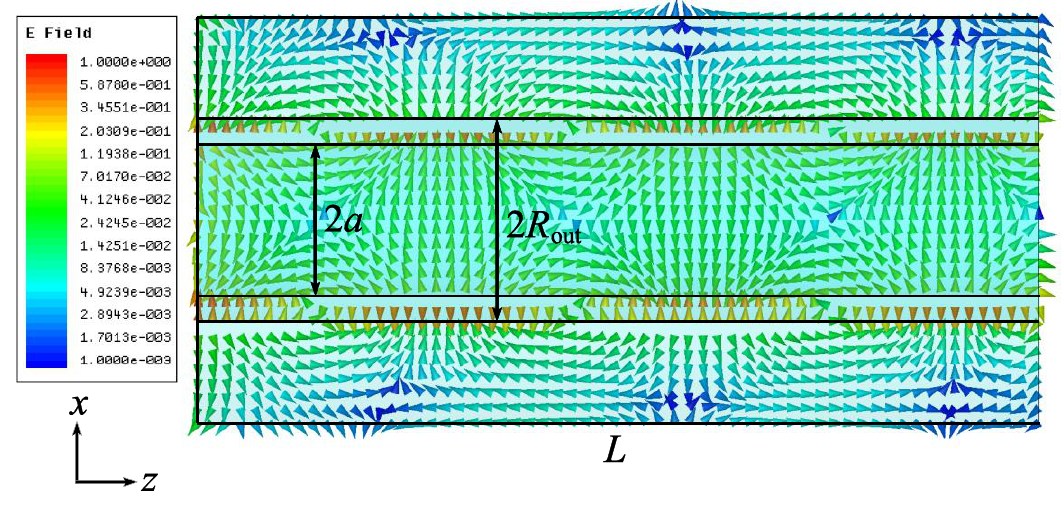
Figure 10. Re{ E(x,y,z) }, phase dependent electric vector field in the xz plane.